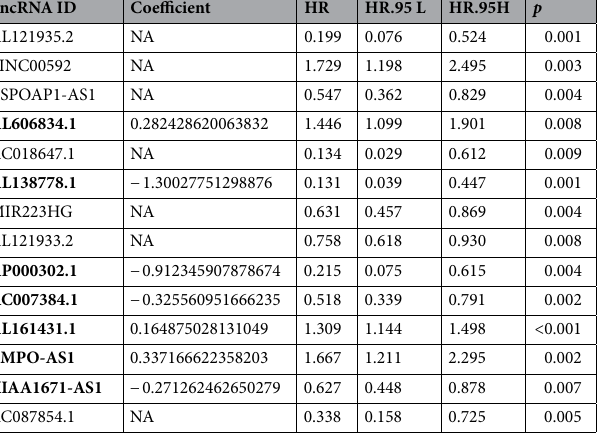
Table 2. Results of univariate Cox analysis and LASSO analysis. Bold biomarker: lncRNAs used for prognostic signature construction; HR. 95 L: hazard ratio 95% low limit; HR. 95 H: hazard ratio 95% high limit; NA: not